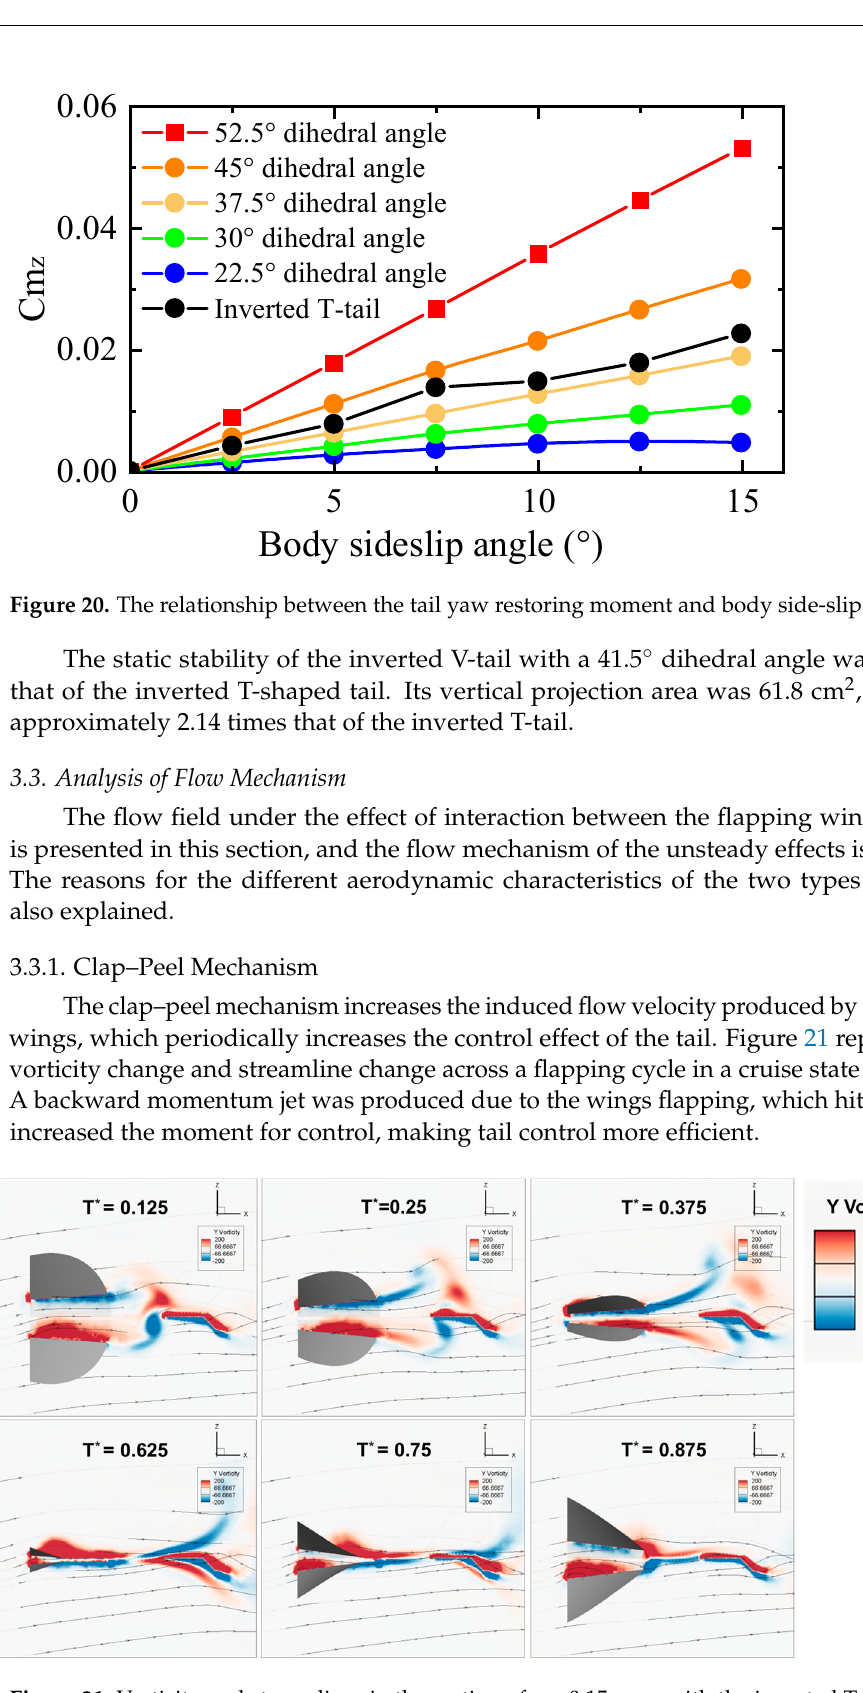
Figure 21. Vorticity and streamlines in the section of y = 0.15 span with the inverted T-tail.